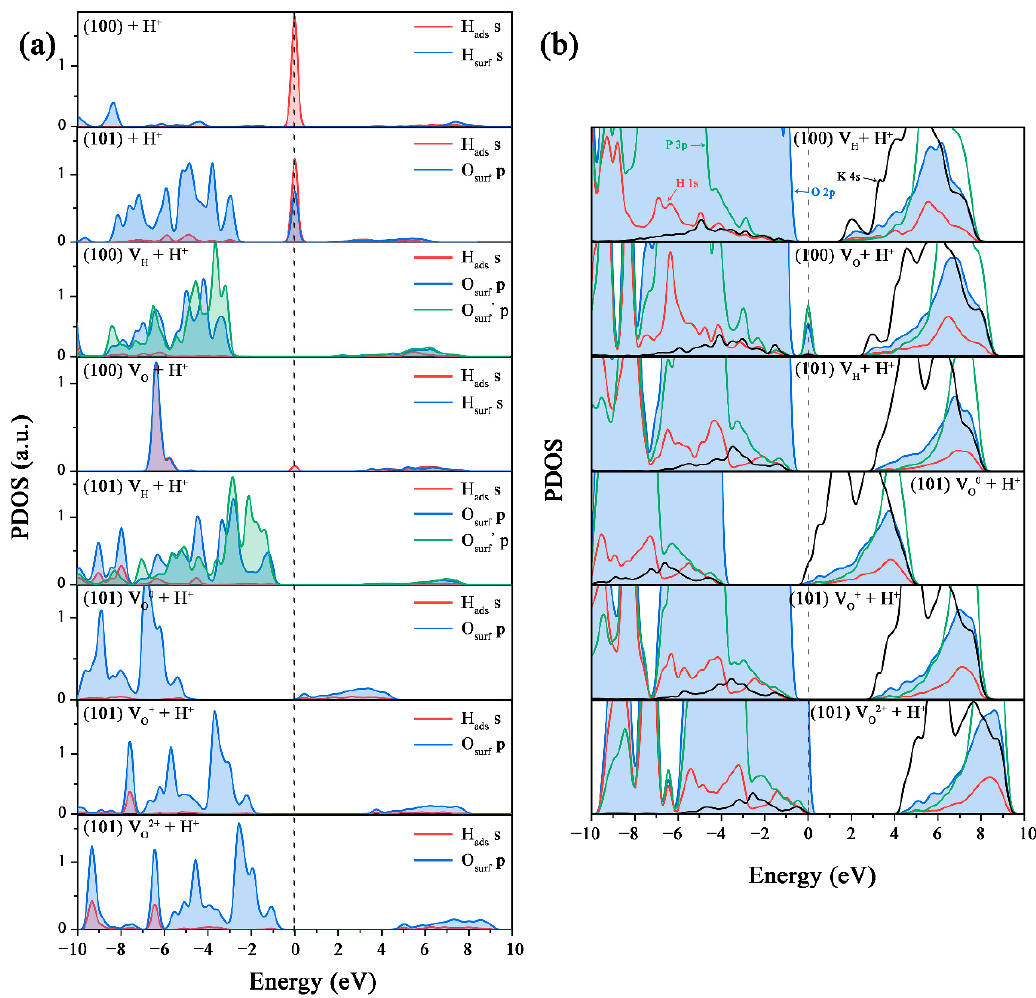
Figure 5. ( a ) Partial density of states of the adsorbed H + ions and the adjacent surface atoms on the (100) and (101) surfaces; ( b ) partial density of states of the H + adsorbed (100) and (101) surfaces with V H and V O defects.